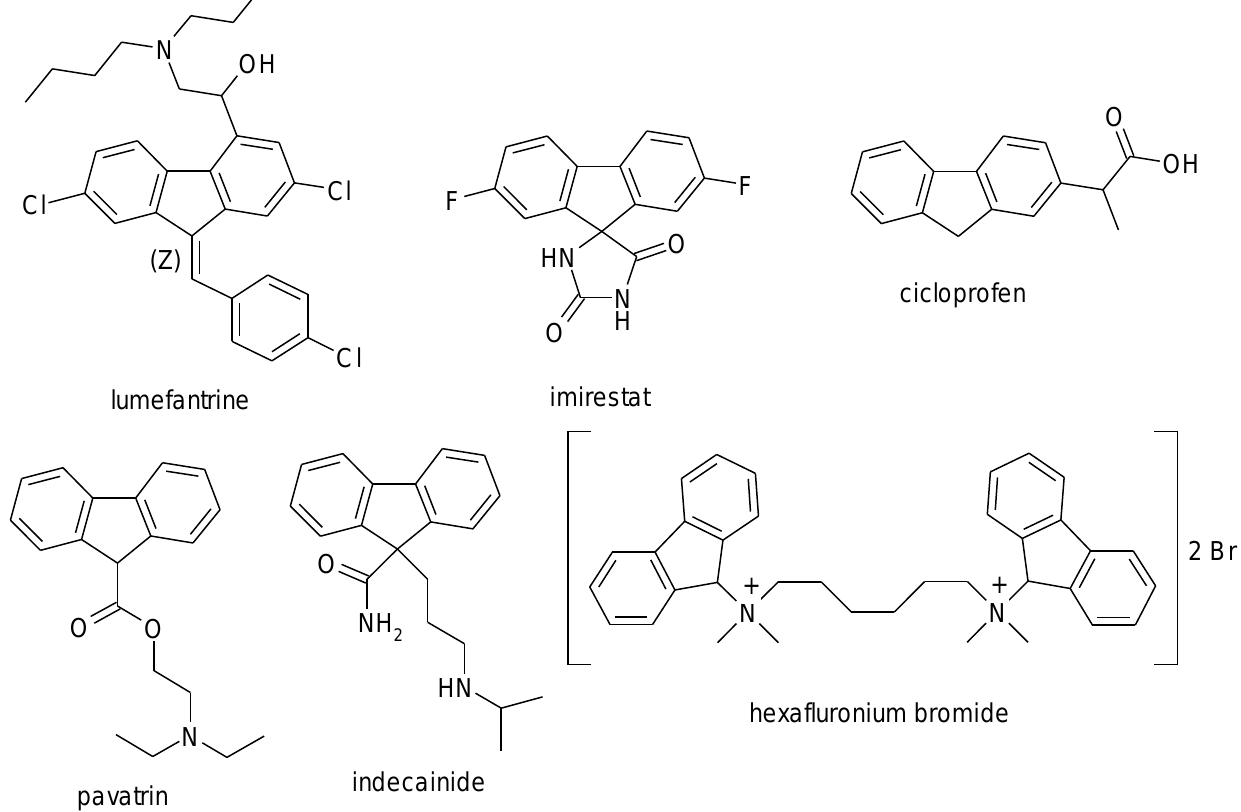
Figure 1. Fluorene—core drugs.